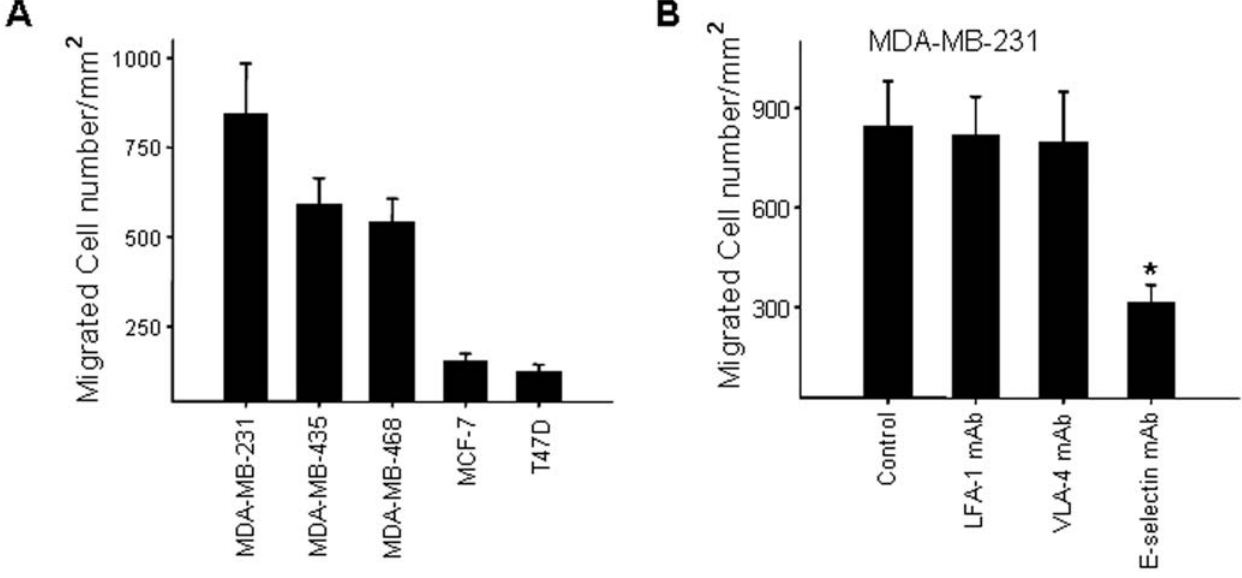
Figure 1. Transendothelial migration of breast cancer cells. A: differential migration of breast cancer cells across HUVEC monolayers pre- activated with TNF- a . B: migration of MDA-MB-231 across HUVEC monolayers in the presence of anti-E-selectin, anti-ICAM-1, and anti-VLA-4 antibodies (25 m g/ml each), respectively. HUVEC monolayers were pre-incubated with endothelial medium containing 25 ng/ml TNF- a for 6 h, and migration was terminated after overnight incubation at 37 u C. All data are expressed as the mean 6 SD ( n =3) of a typical experiment and similar results were obtained in at least three separate experiments.